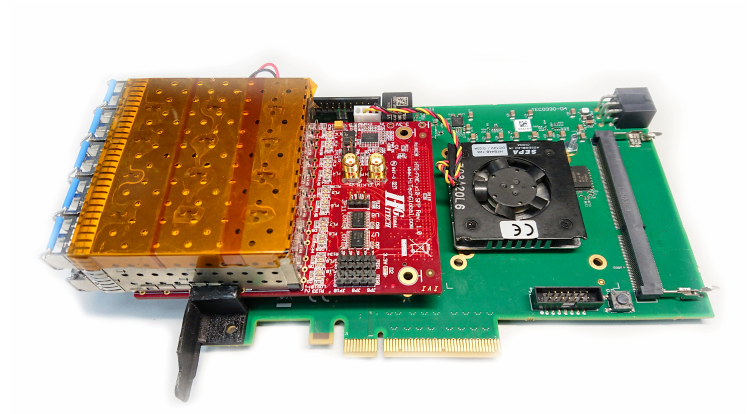
Figure 1. The Trenz Electronics TEC0330-4 coupled with the HiTech Global HTG-FMC-X10SFP +